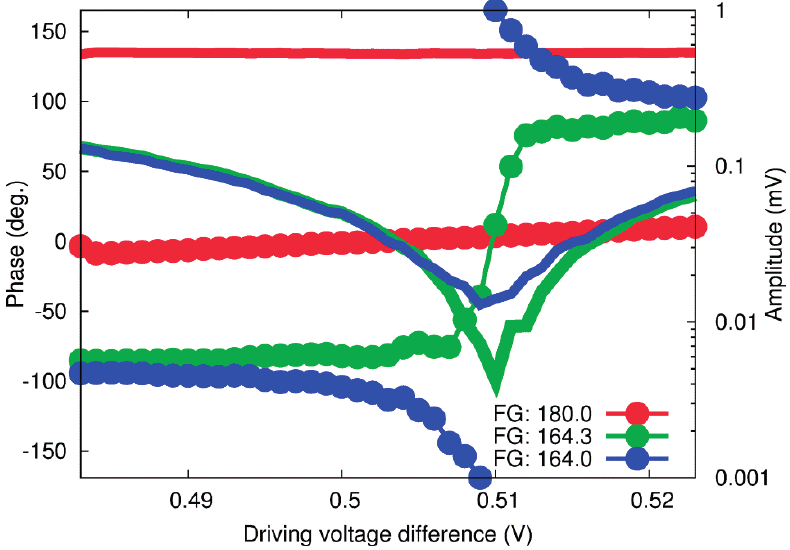
Figure 3. OPBS-based amplitude (plain lines) and phase (dotted lines) response for pure water at three phase differences between the two optical